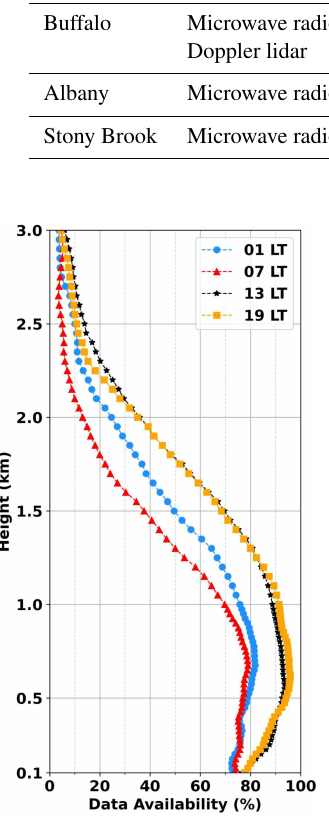
Figure 2. The DL data availability during four different hours at the NYSM Profiler Network site at Albany during May–August 2021. The NWS RS launches are at 12:00UTC (07:00LT) and at 00:00UTC